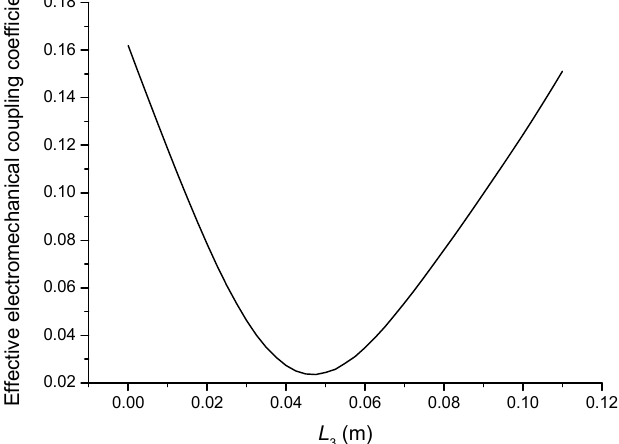
Figure 13. Theoretical relationships between the resonance/anti-resonance frequencies and length L 3 at the second mode (Position effect of PZT-3).